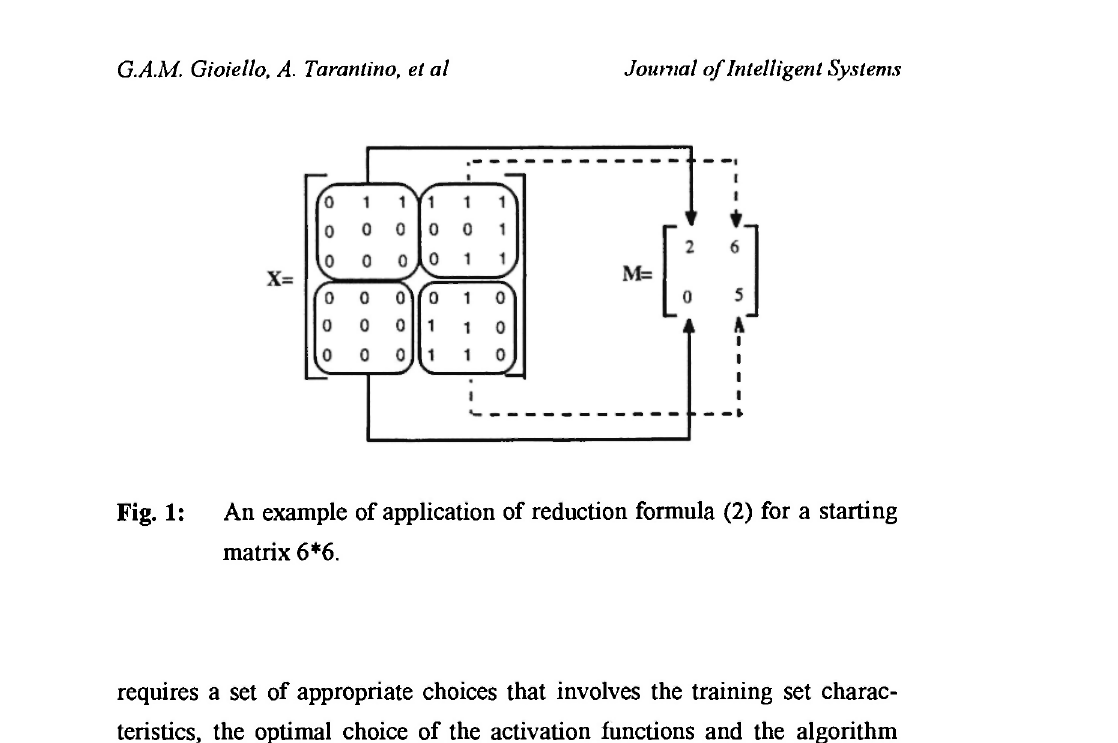
Fig. 1: An example of application of reduction formula (2) for a starting matrix